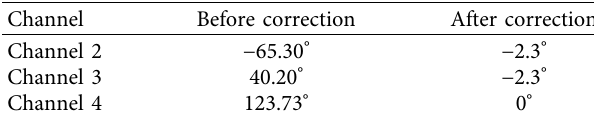
Figure 12: Diagram of phase difference correction experiment. Table 1: Correction of phase difference.